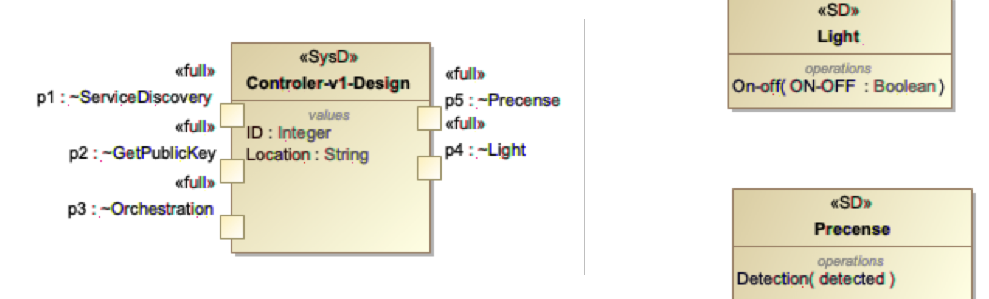
Figure 6. The SysML black box model of the streetlight controller and its consumed application